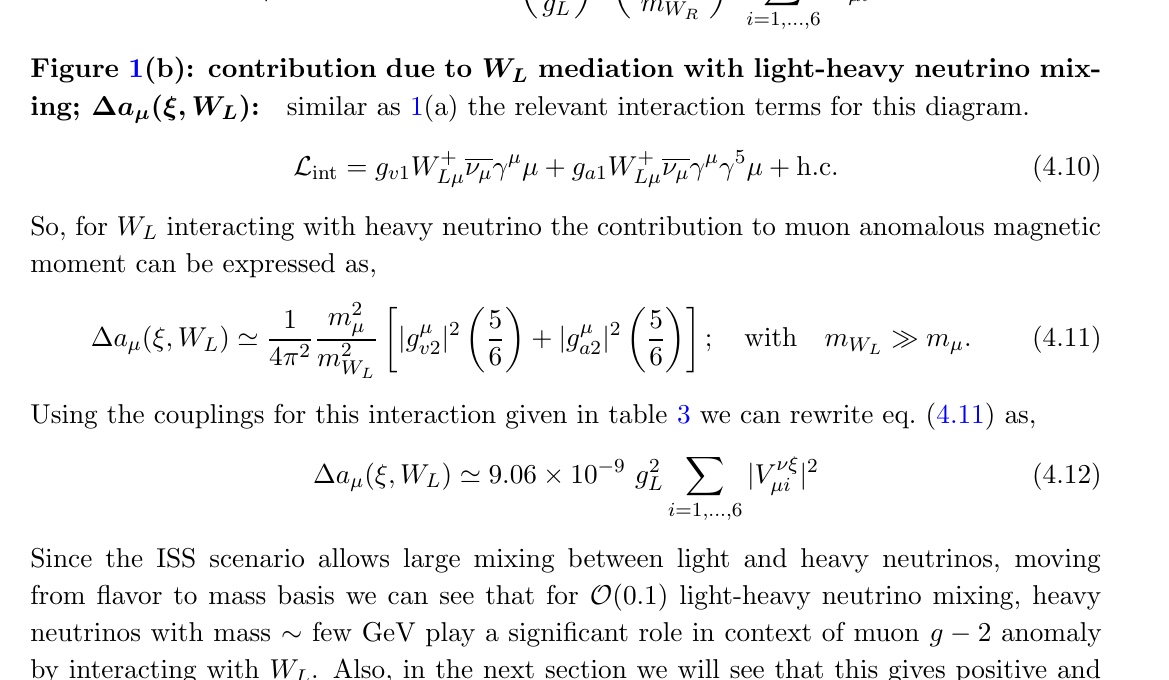
mediation; (cid:1) a R